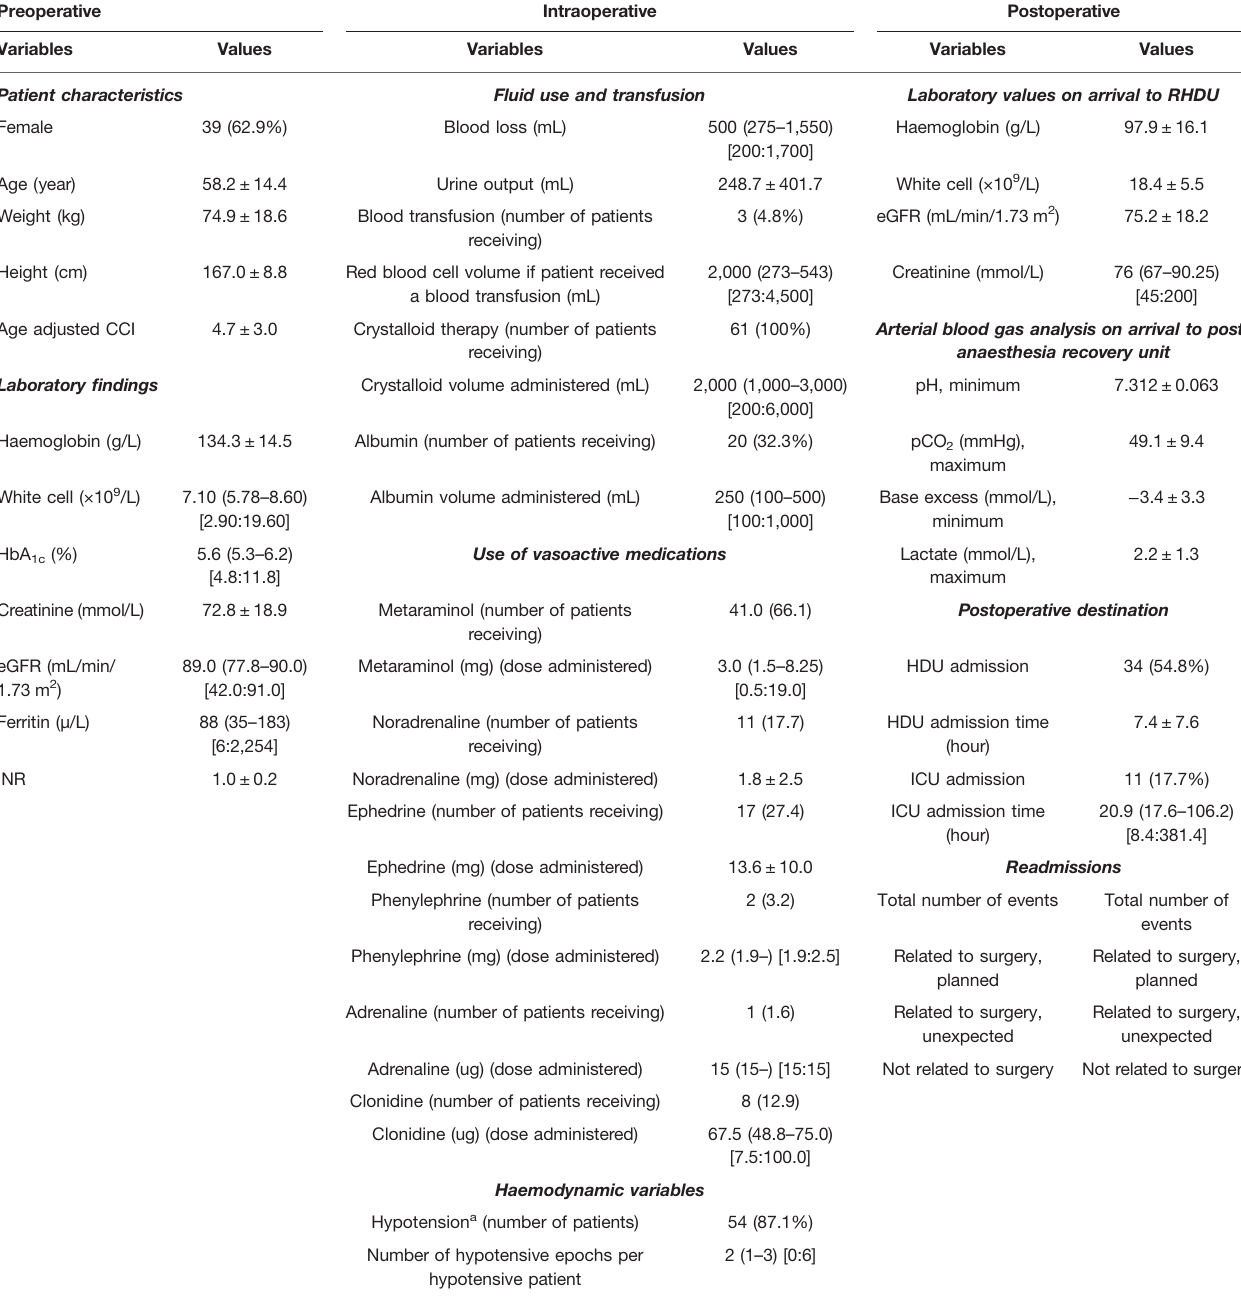
TABLE 1 | Baseline patient characteristics, perioperative laboratory fi ndings and postoperative